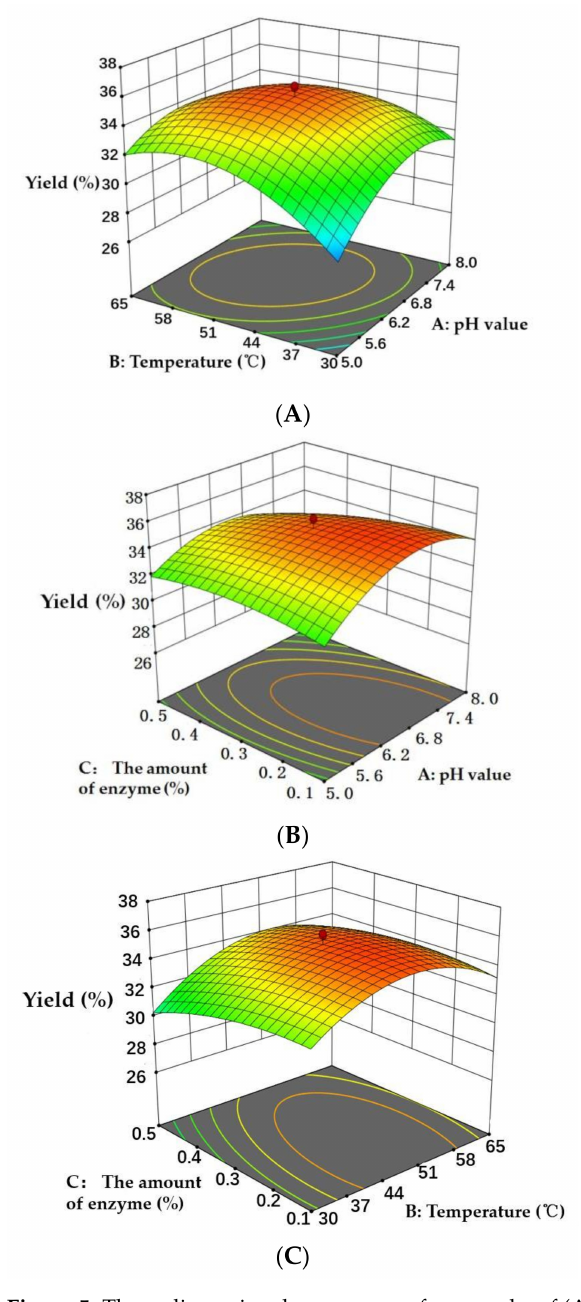
Figure 5. Three-dimensional response surface graphs of ( A ) temperature ( ◦ C) and pH value, ( B ) pH value and the amount of enzyme (%), and ( C ) temperature ( ◦ C) and the amount of enzyme (%) on the yield of peptides. Table 5. The molecular weight of the prepared